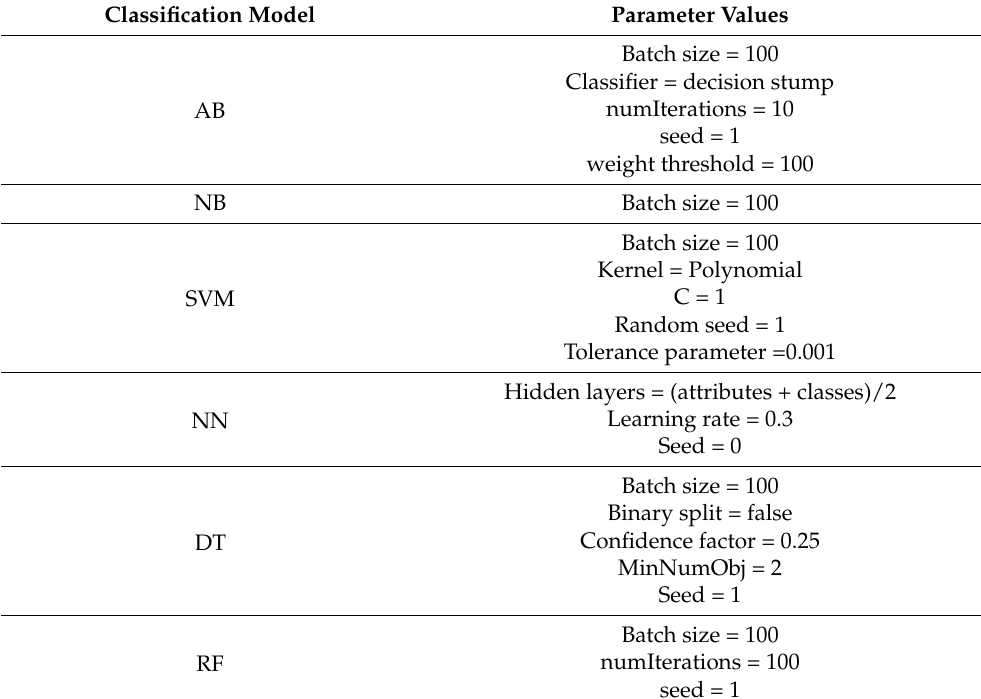
Table 4. Classification models parameter